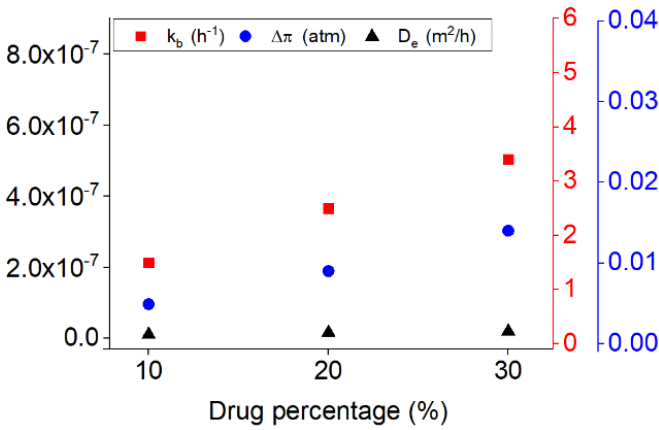
Figure 6. The variation of the release parameters for the drug release from PU films with the three different percentages of the drug (10%, 20%, and 30%) at the flow rate of 7.5 mL/s.